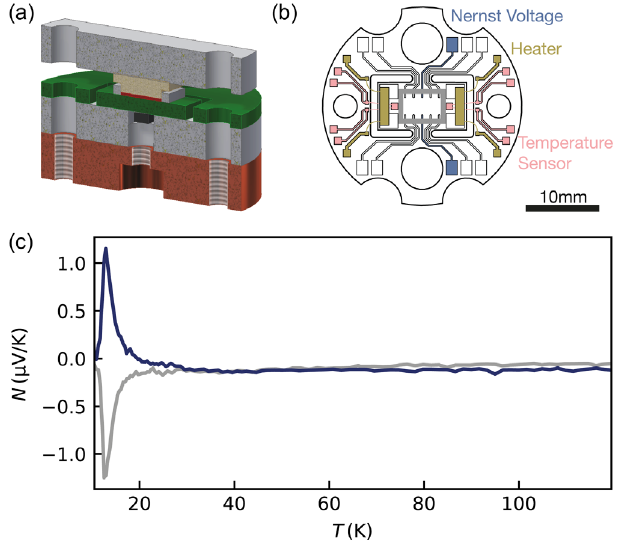
FIG. 6. Experimental setup. (a) Sample (red) pressed on top of a circuit board (green) using a PMMA piston (beige). The sample space is encapsulated using nonconductive epoxy glue. The base temperature is measured with a sensor (black) pressed against the bottom of the circuit board. The sample and circuit board are mounted on the cold finger of a cryostat (copper) using titanium screws (not shown), with spacers made of PMMA (gray). (b) Schematic of the circuit board. The sample compartment is indicated by a gray rectangle. A temperature sensor is placed on each side of the sample in a milled pocket, encapsulated by thermally conductive epoxy glue. Resistive heaters are placed on each side. The Nernst signal is measured with the indicated indium-coated contacts in the center of the sample compartment. The othercontacts areusedforfour-pointresistancemeasurements. (c) Transverse voltage at þ 15 T (blue) and − 15 T (gray). For the data shown in the main text, the Nernst signal is evaluated as half of the difference between signals measured at opposite